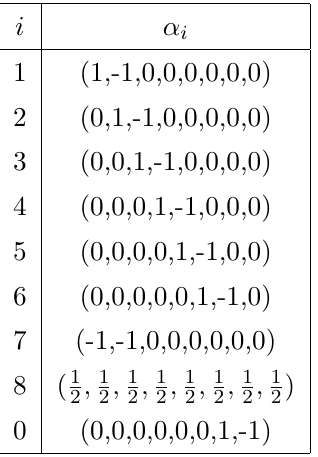
Table 1 . Simple roots ( i = 1 , . . . , 8) and highest root ( i = 0) of E 8